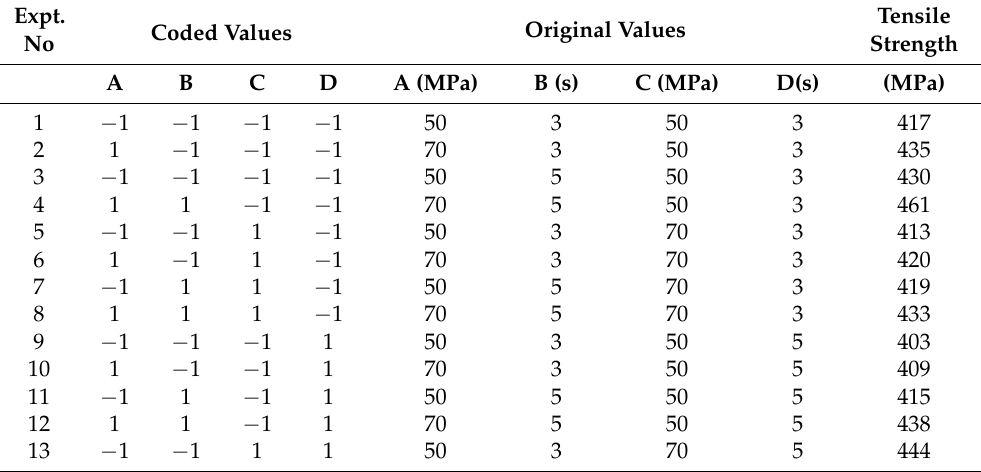
Table 4. Results of the experiment and the design matrix.